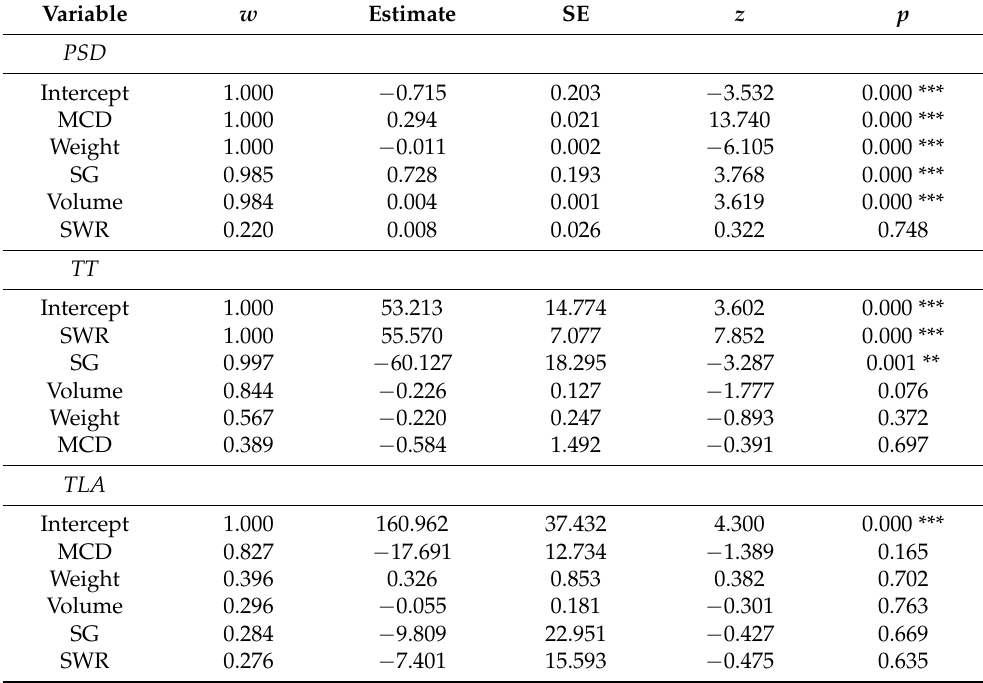
Table 2. The inference and importance ( w ) of various predictors considered under all possible models were used to support the best model to account for the effect of different physical characteristics of seeds ingested by Tibetan macaques on PSD and passage time.